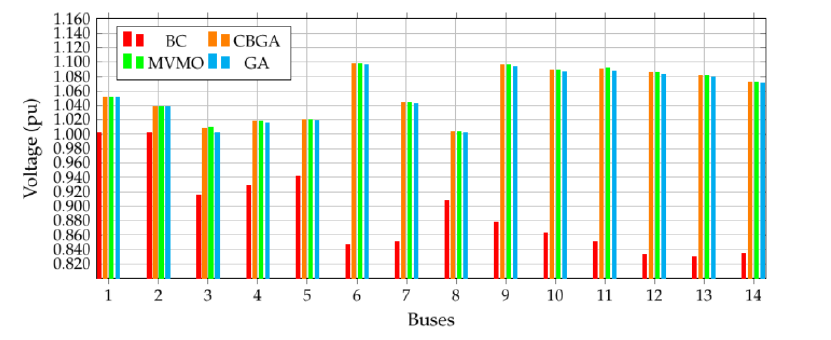
Figure 11. Voltage profile of the IEEE 14-bus system considering different methodologies.